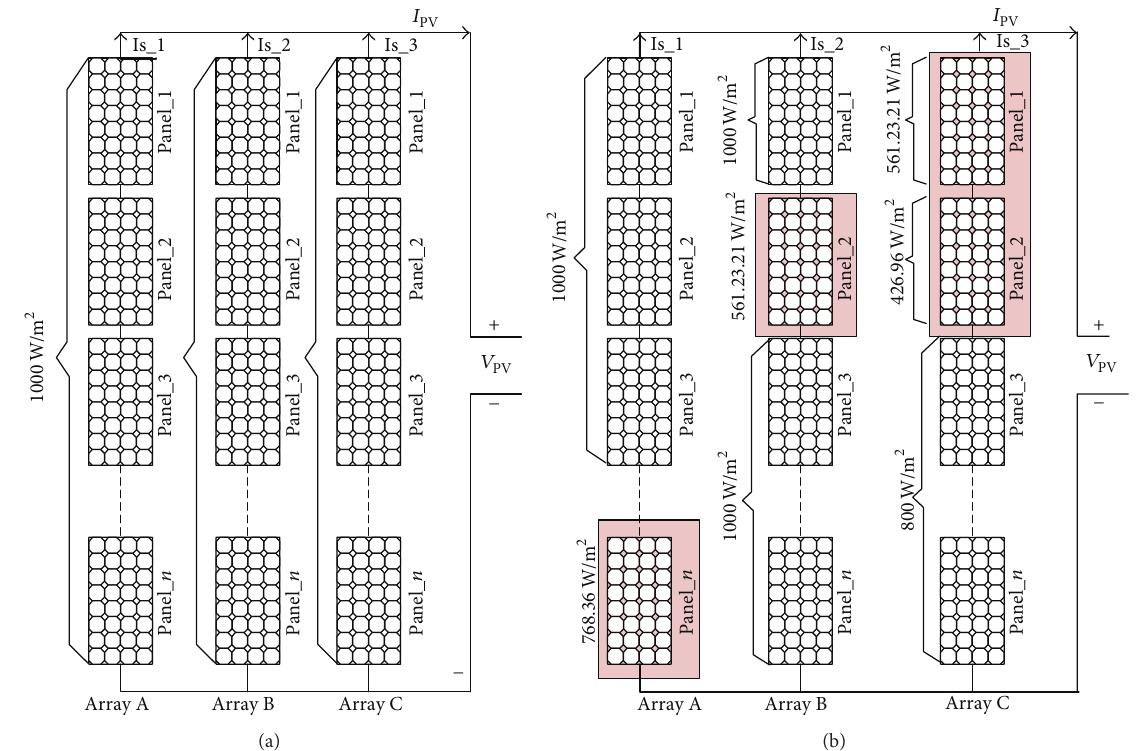
Figure 7: Centralized PV system. (a) Uniform solar irradiance. (b) Shaded system.